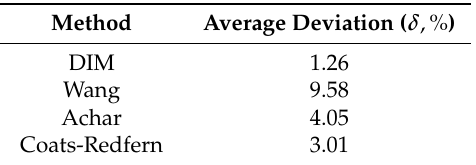
Table 5. Average deviation comparison of different